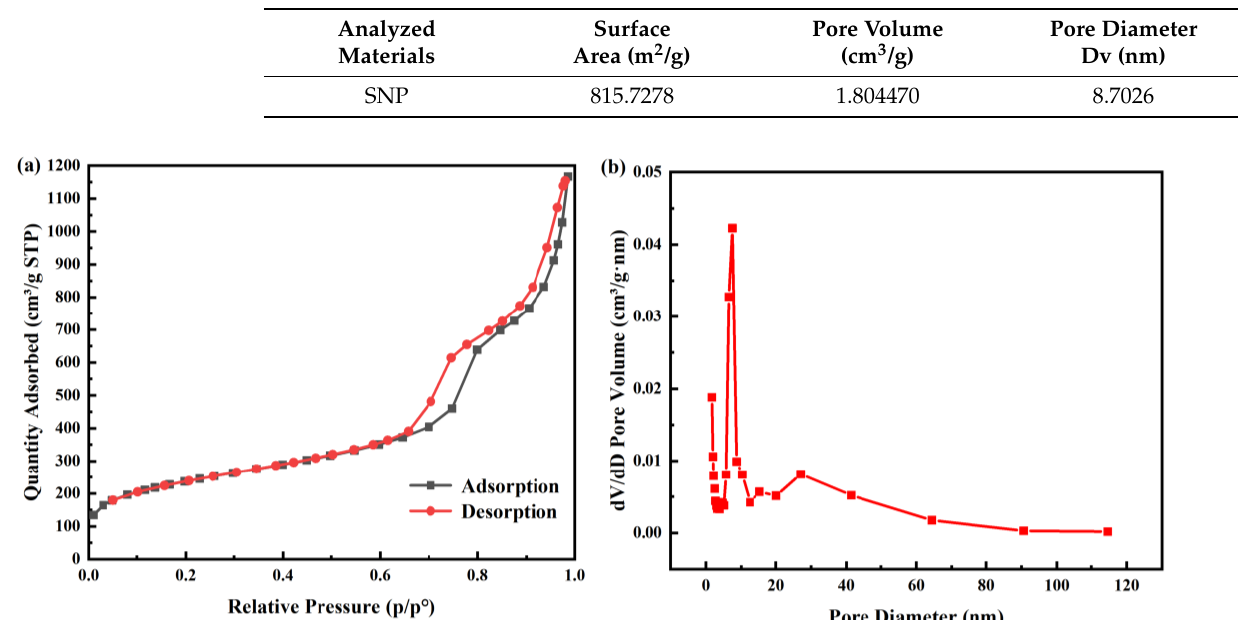
Figure 2. ( a ) N2 adsorption/desorption isotherms of SNP and ( b ) pore size distribution of SNP.